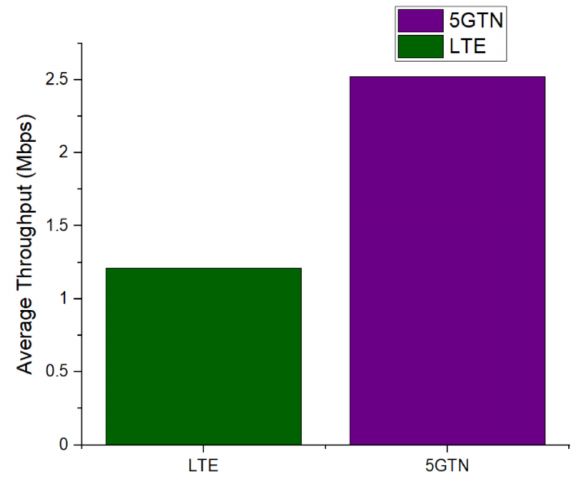
Figure 10. Average throughput comparison between LTE and